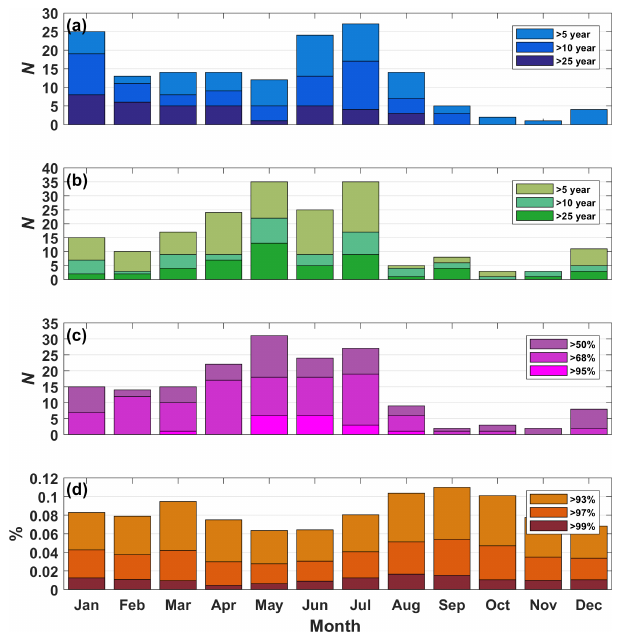
Figure 7. Seasonal distribution of sea-level components associated with extreme storm-tide and skew-surge events: (a) extreme storm tide, (b) extreme skew surge, (c) MSLA and (d) high tide ≥ 93rd percentile (includes all high tides, not just those associated with ex- treme storm-tide events). N denotes number of